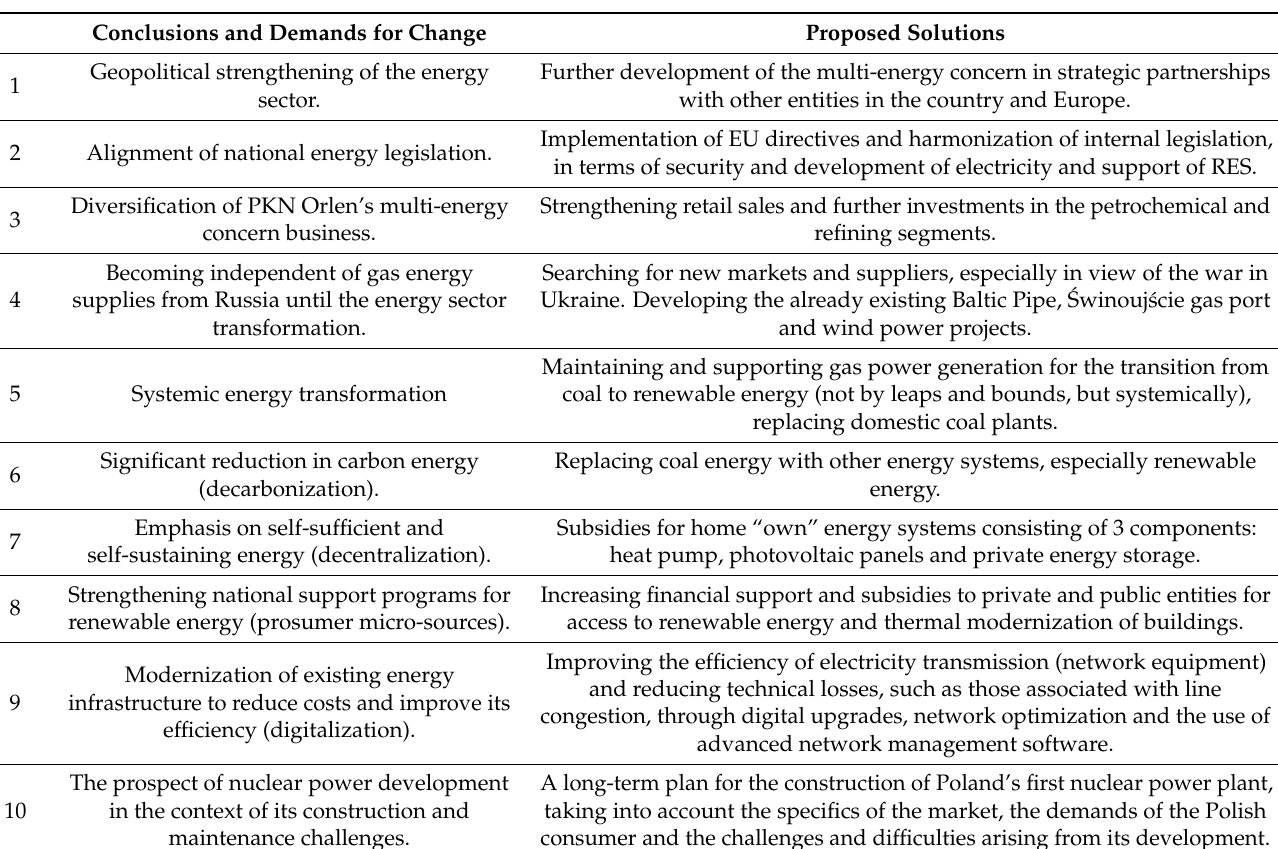
Table 9. Examples of proposed directions of changes in the energy sector in Poland in the near future (2022–2040